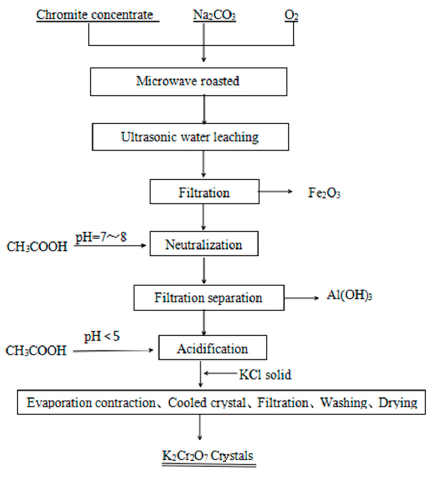
Figure 4. Flowchart for the preparation of K 2 Cr 2 O 7 from chromite concentrate with Na 2 CO 3 .